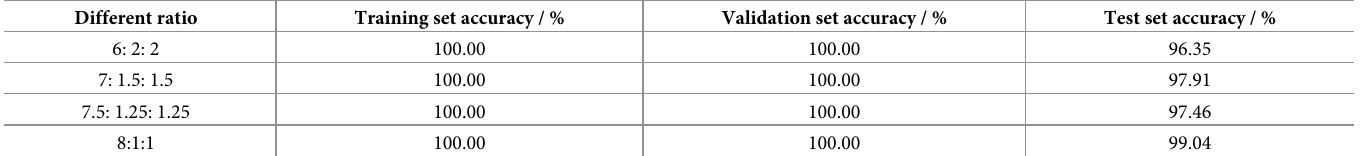
Table 5. Accuracy of results of different groups. Different ratio